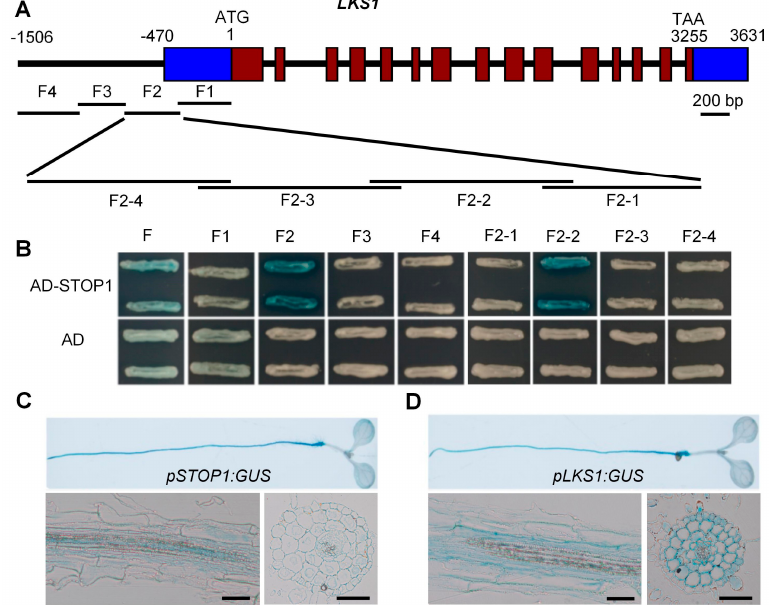
Figure 1. STOP1 can bind to the LKS1 promoter region in vitro. ( A ) Schematic structure of LKS1 gene and the fragments segmented from the LKS1 promoter. The adenine residue of the translational start codon (ATG) is assigned position +1. The blue boxes represent the 5 ′ -UTR (left, − 470 to − 1) and 3 ′ -UTR (right, 3256 to 3631), respectively. The promoter region F was divided into four fragments F1 ( − 382 to − 1 bp), F2 ( − 757 to − 364 bp), F3 ( − 1078 to − 738 bp), and F4 ( − 1506 to − 1061 bp). Then, F2 was divided into F2-1 ( − 460 to − 361 bp), F2-2 ( − 560 to − 441 bp), F2-3 ( − 660 to − 541 bp), and F2-4 ( − 760 to − 641 bp). ( B ) Yeast-one-hybrid assays showing that STOP1 can bind to the fragments of LKS1 promoter. The coding sequence of STOP1 was constructed into the vector pB42AD. AD refers to the empty vector expressing the AD domain alone. LacZ was used as a reporter gene, driven by the fragments of LKS1 promoter in yeast. ( C,D ) GUS staining analyses of STOP1 ( C ) and LKS1 ( D ) expression in 7 day old Arabidopsis seedlings. The lower panels show the vertical (left) and cross-sections (right) of roots, respectively. Bars = 50 μ m.